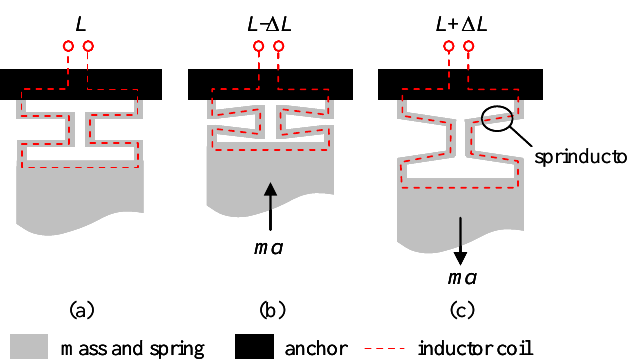
Figure 1. Schematic of proposed complementary metal oxide semiconductor micro-electromechanical systems (CMOS-MEMS) inductive accelerometer showing suspended mass and sprinductor: ( a ) Without acceleration, ( b ) compressed sprinductor and reduced inductance under acceleration, and ( c ) stretched sprinductor and increased inductance under acceleration.